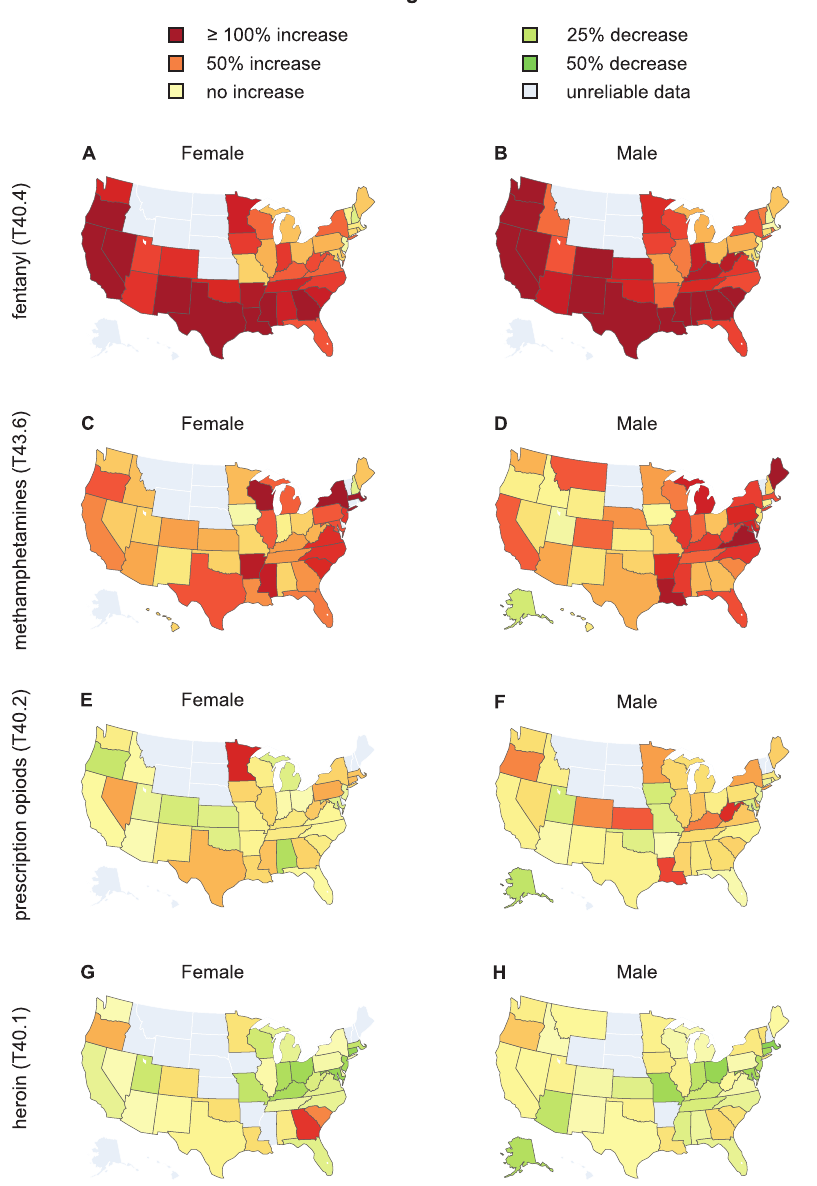
Fig 4. Percentages of change to the crude rate between 2019 and 2020 stratified by gender for fentanyl (T40.4, panels A, B), methamphetamines (T43.6, panels C, D), prescription opioids (T40.2, panels E, F), and heroin (T40.1, panels G, H), in the United States. In states shown in dark red, crude rates more than doubled while green indicates that crude rates decreased between 2019 and 2020.